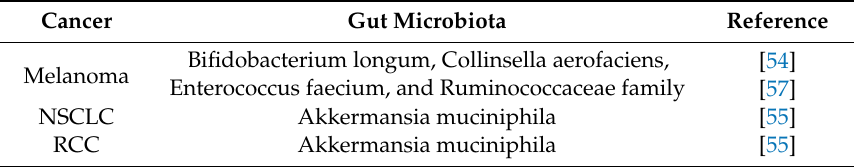
Table 4. Gut microbiota associated with favorable clinical outcome in patients treated with